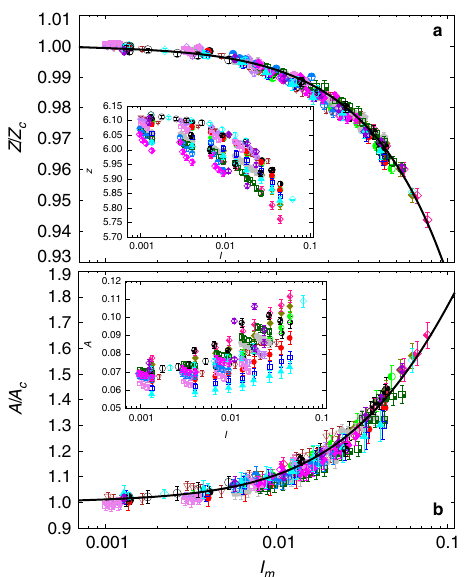
Fig. 5 Scaling of microstructural variables. Number density Z of capillary bonds ( a ) and bond orientation anisotropy A ( b ) as a function of the generalized inertial number I m de fi ned by Eq. (1) with α ≃ 0.062 and β ≃ 0.075, for sets of parameters. The error bars represent the standard variation over steady-state fl ow, and the symbols and their colors are the same as those in Fig. 2. The solid lines are fi tting forms similar to those used for μ ∕ μ c and Φ ∕ Φ c with different parameter values; see Supplementary Note